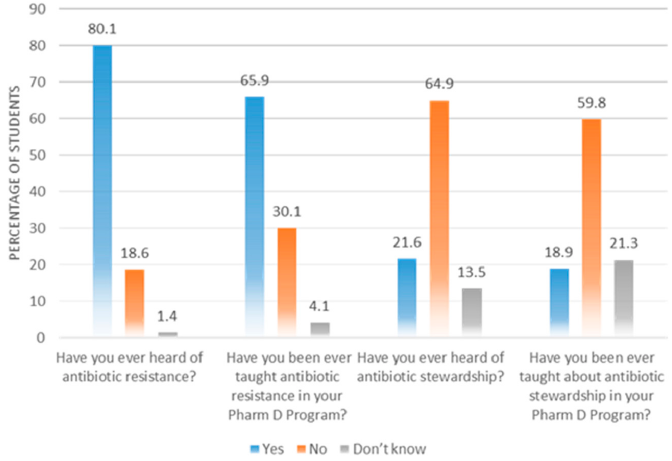
Figure 2. Awareness of students about antibiotic resistance and stewardship. A large number of respondents ( n = 126, 42.6%) had an average level of ABR related